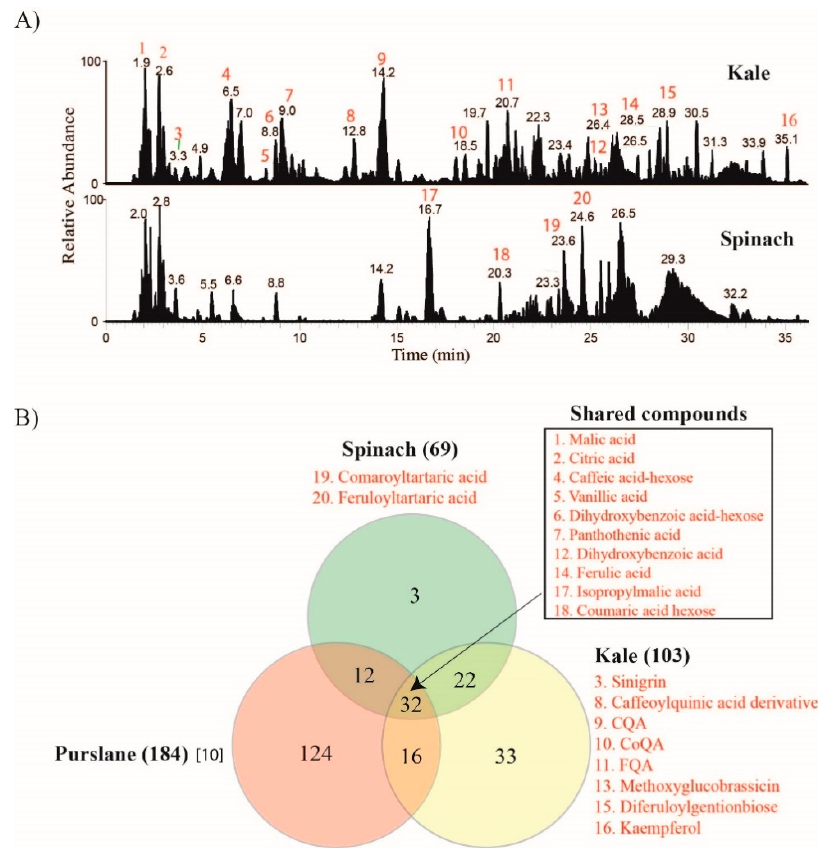
Figure 1. Comparative phytochemicals content analysis of leafy greens by LC-MS/MS. ( A ) Comparison of total ion chromatograms of kale (top panel) and spinach (bottom panel). ( B ) Venn diagram showing the number of compounds identified in kale (total 103; unique 33), spinach (total 69; unique 3) and purslane (total 184; unique 124) and those shared among the greens.